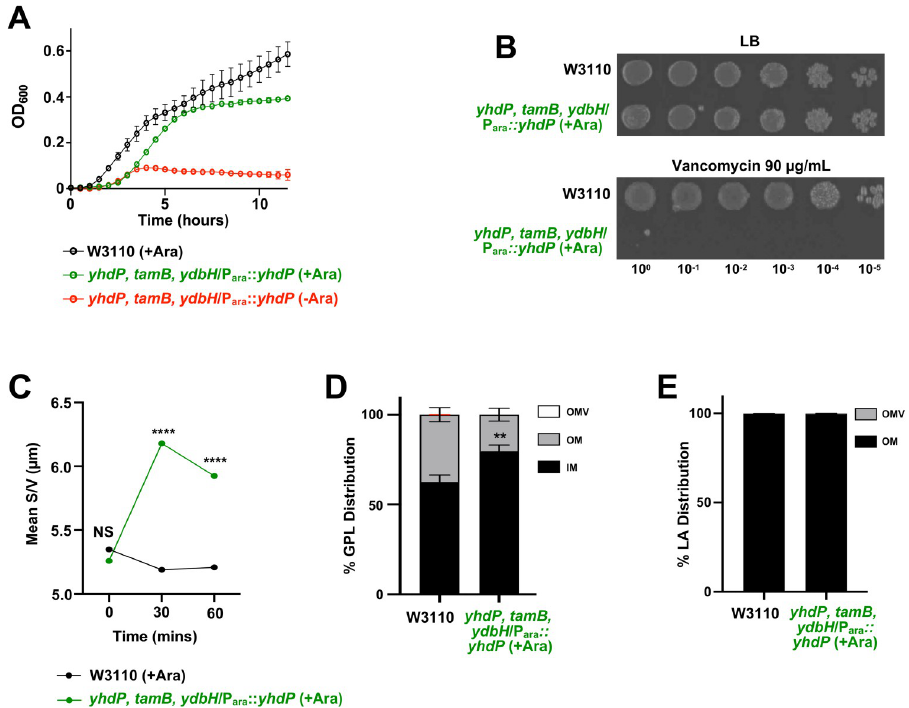
Fig 6. Depletion of AsmA-like functions leads to accumulation of GPLs in the IM. (A) Growth of yhdP , tamB , ydbH mutants. Strains were monitored by OD 600 every 30 minutes at 37˚C and error bars represent SD from technical triplicates. (B) Serial dilutions of indicated strains were spotted on LB plates containing either vancomycin, or no antibiotic. Plates were incubated at 37˚C. (C) Surface area/volume measurements of cells at the beginning of 32 P- labeling after cells grew for 3 hours ( S5B Fig ). Cell width and length of listed strains were measured using MicrobeJ software after strains were inoculated with 32 P i and imaged at 1000x on agarose pads, S/V was calculated using cell width and length. T-test used between strains. 0.0001 > P ���� . (D) 32 P-labeled membrane separation. Listed strains were inoculated with 32 P i after 3 hours of growth for 60 mins. Inner and outer membrane fractions were separated by a 3-step sucrose gradient and OMVs (error bars in red) were collected separately. The % of 32 P-incorporation indicating GPL levels was performed in biological triplicates. T-test used between strains. 0.01 > P �� . (E) LPS distribution across OM and OMV. 60 minutes after the start of 32 P-labeling, lipid A from strains W3110 and W3110 yhdP , tamB , ydbH/ P ara :: yhdP grown in arabinose was extracted from the collected OM and OMV fractions and lipid A distribution was calculated from TLC densitometry.